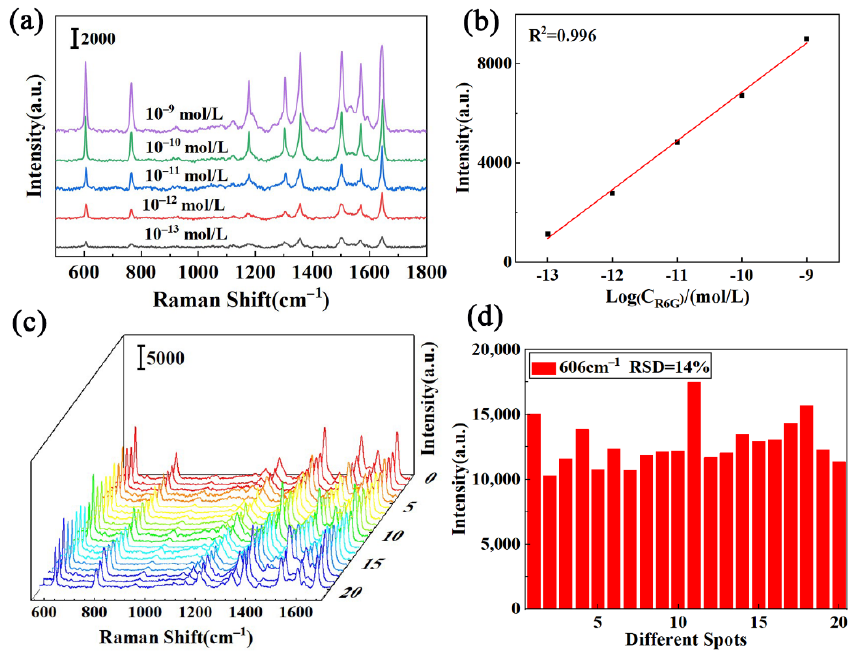
Figure 6. ( a ) SERS spectra of dendritic Au–Ag nanoparticles adsorbed to different concentrations of R6G. ( b ) Plot of intensity at 1645 cm − 1 of R6G with different concentrations. ( c ) Raman spectra of the 10 − 7 mol/L R6G and ( d ) the corresponding SERS intensity at 606 cm − 1 , which were obtained from 20 different random locations of the Au–Ag